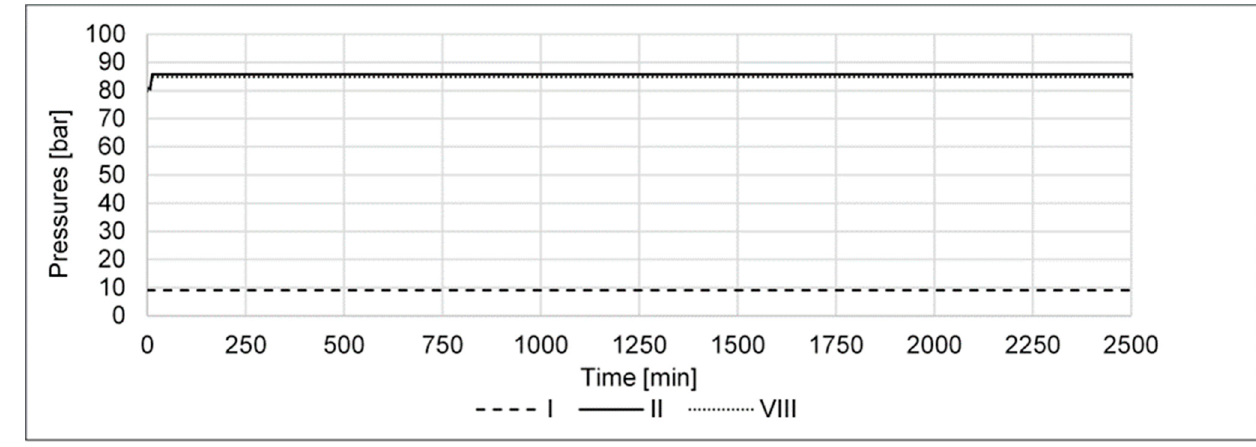
Figure 11 . Selected pressure values of scenario (e). Figure 11. Selected pressure values of scenario (e).